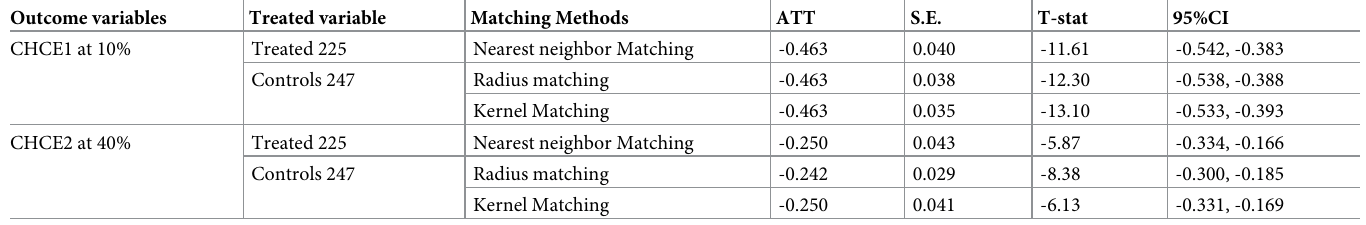
Table 6. The results of the average treatment effects of community-based health insurance on outcome variables were used by using different propensity score matching algorithms in Kutaber district, Ethiopia (n = 472). Outcome